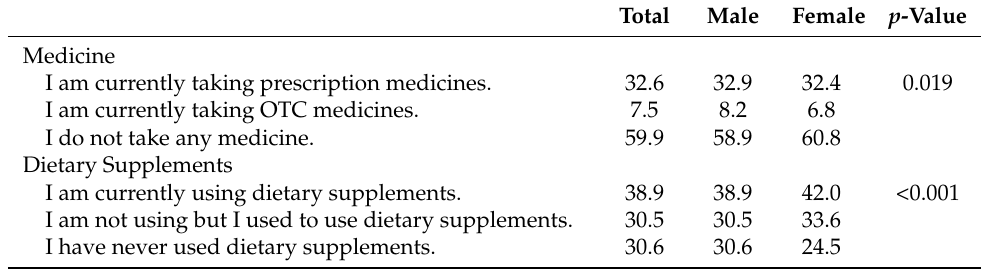
Table 2. The prevalence of medicine and dietary supplement usage.